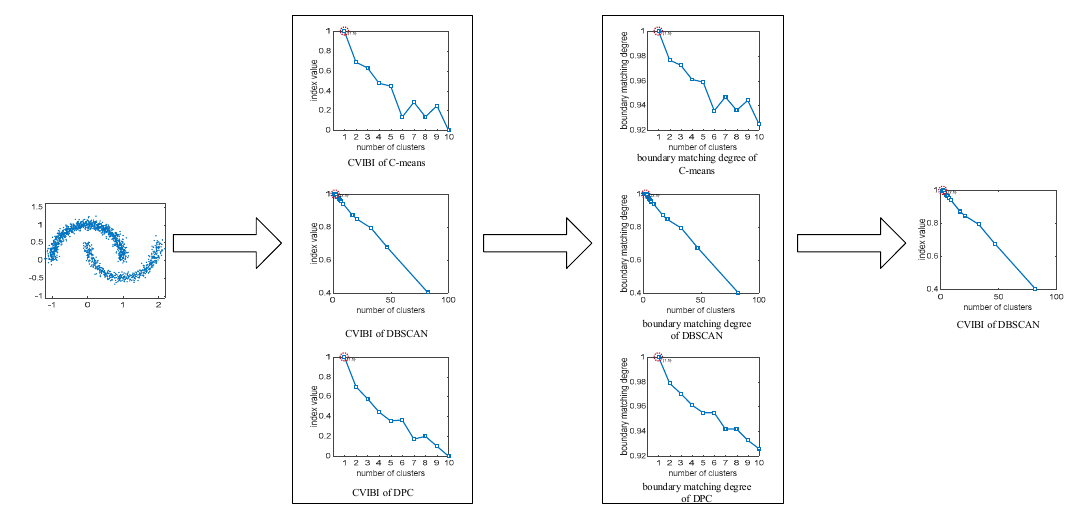
Figure 12. Evaluating the process of CVIBI on the multi-peak dataset.